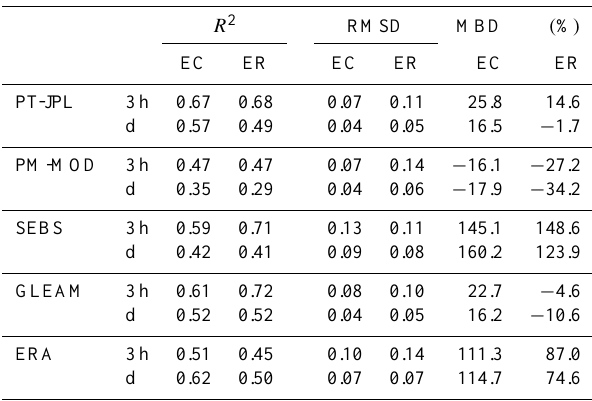
Table 4. Summary of 24 station average statistics for 3-hourly and daily satellite forcing. ERA denotes the agreement of ERA-Interim evapotranspiration with the in situ reference evapotranspiration. For other abbreviations, see Table 3. RMSD is given in millimeters per hour for both 3-hourly data (3h) daily data